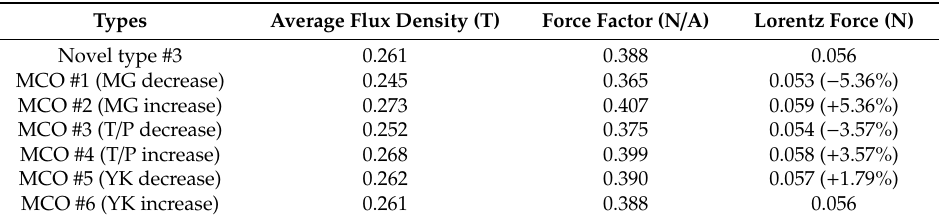
Table 10. Analysis result comparison of the magnetic circuit